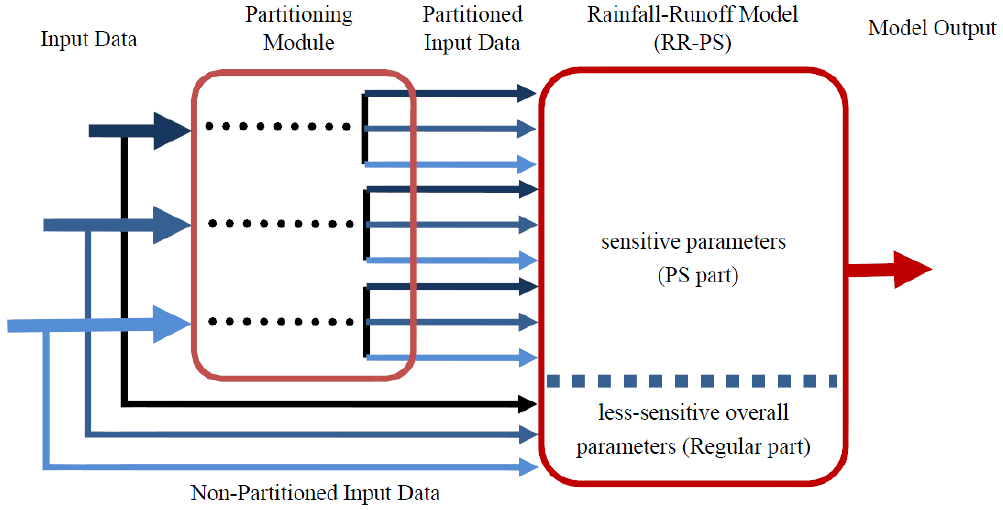
Figure 3. Diagram of Rainfall Runoff-Partitioning Scheme (RR-PS) model.